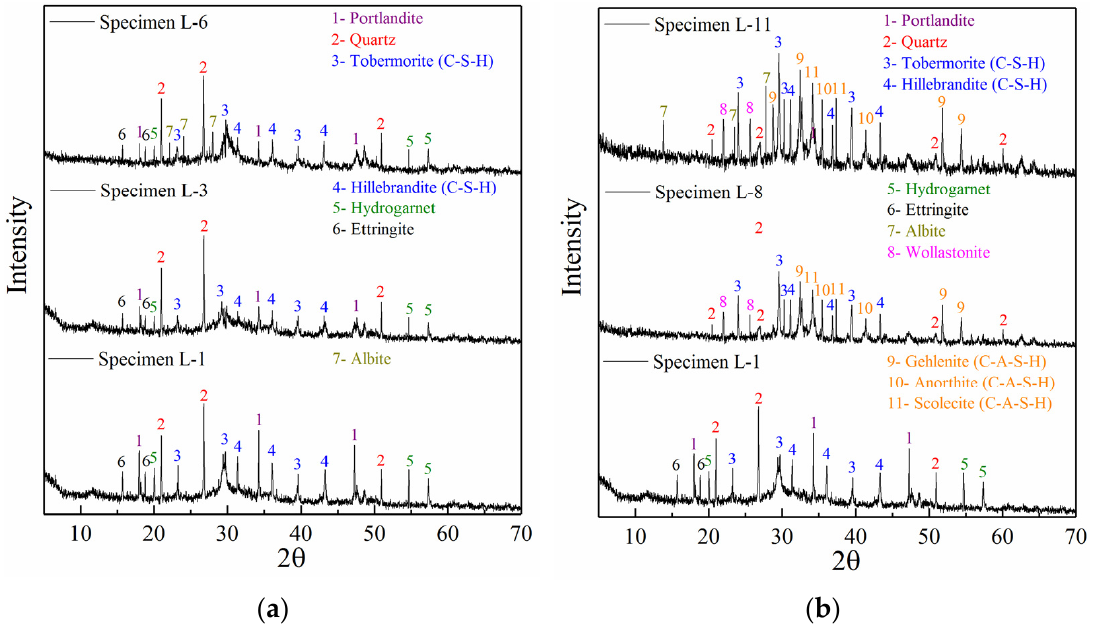
Figure 3. Crystal structure analysis of PC and GBFS alkali-activated grouting specimens. ( a ) PC grouting specimens. ( b ) GBFS alkali-activated grouting specimens.